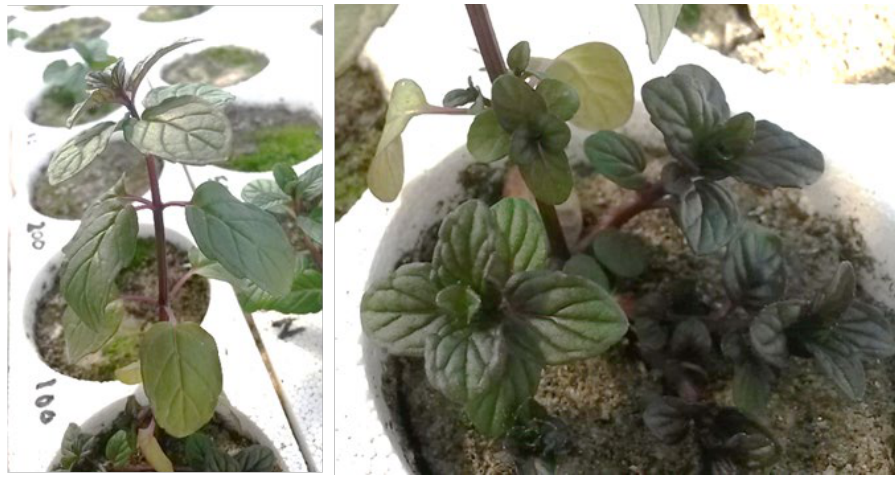
Different letters within each column indicate significant differences according to the Tukey’s test ( p ≤ 0.05). 1 Naked = nodes of stolon not encapsulated. 2 The artificial endosperm of each synthetic seed was enriched with